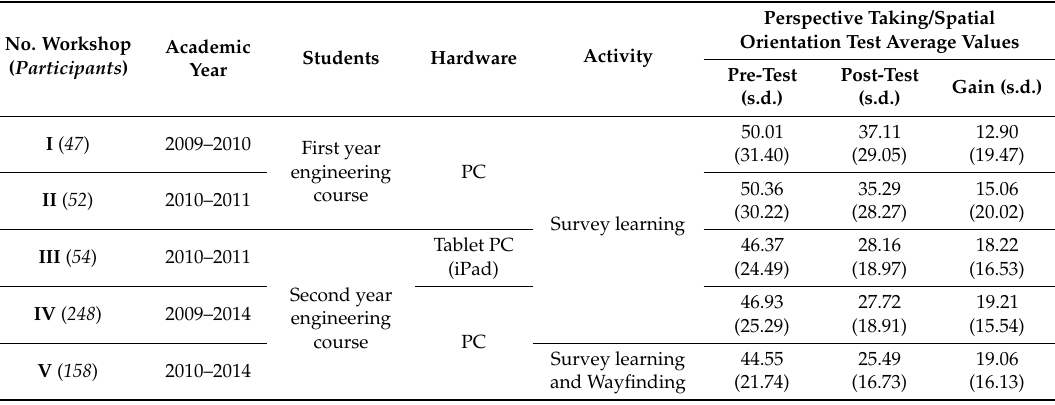
Table 1. Workshops with the spatial data infrastructure (SDI) geospatial application for educational purposes: spatial orientation skill improvement average